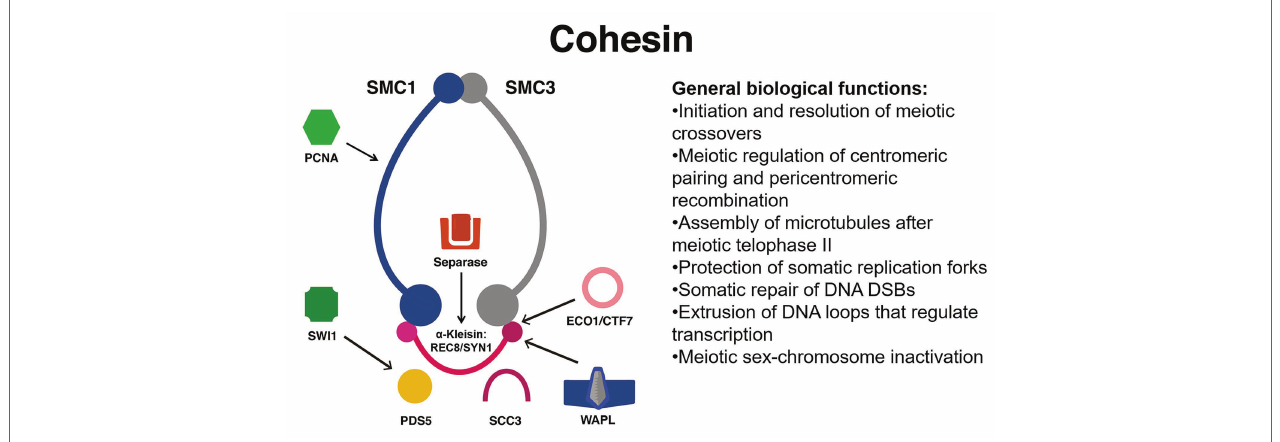
FIGURE 1 | Simplified interaction network between the eukaryotic structural maintenance of chromosomes (SMC) cohesin complex and its functional partners. The plant cohesin complex is proposed to be a ring that stably entraps DNA molecules and facilitates meiotic recombination, centromeric pairing, protection of replication forks, extrusion of chromatin loops, and inactivation of sex chromosomes. These processes are facilitated by locking and unlocking of the ring via the simultaneous activity of promoters of cohesion ECO1/CTF7, PDS5, and SWITCH1 (SWI1). Other particularly important factors are PCNA, which facilitates DNA repair and operates as a docking platform for ECO1/CTF7, and cohesin dissociating factors that facilitate dislodging or degradation of the kleisin such as Separase and SCC3 or competitors of PDS5 such as WAPL. Not shown: CTF18. ECO1/CTF7, ESTABLISHMENT OF COHESION 1/CHROMOSOME TRANSMISSSION FIDELITY 7, a N-terminal acetyltransferase; DSB, double-strand break; PCNA, PROLIFERATING CELL NUCLEAR ANTIGEN; PDS5, PRECOCIOUS DISSOCIATION OF SISTERS, a HEAT-repeat protein; REC8, RECOMBINATION PROTEIN 8, a meiotic α -kleisin also known as SYNAPTIC 1 and often abbreviated as REC8/SYN1. The yeast mitotic α -kleisin is known as SCC1, SISTER CHROMATID COHESIN 1, which in the Arabidopsis genome is represented by two bona fide orthologs known as SYN2 and SYN4; although a fourth α -kleisin unique to plants called SYN3 is important for both meiosis and mitosis. WAPL, WINGS APART LIKE, a cohesin dissociation